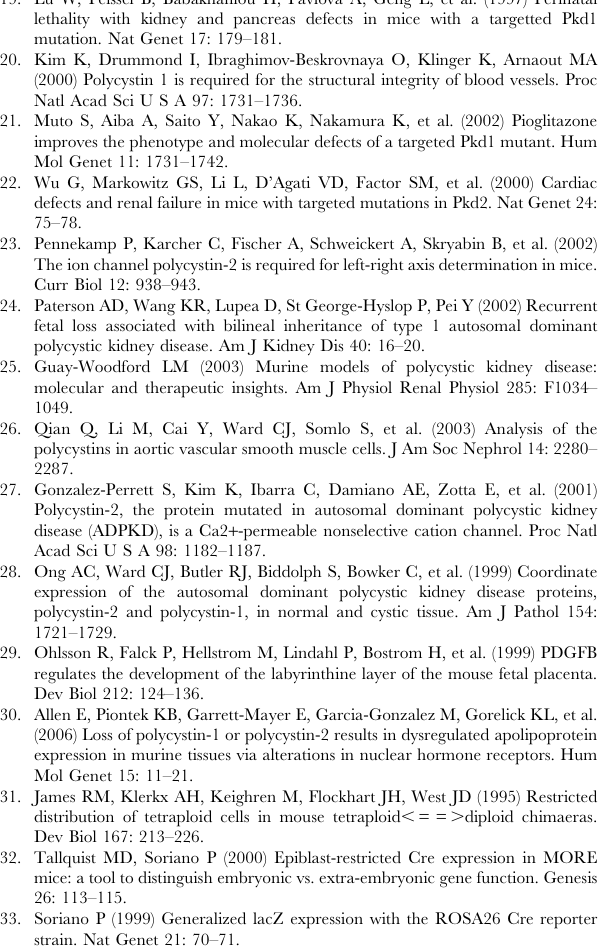
Table S1 Genotypes resulting from Pkd1 + / 2 Intercrosses .